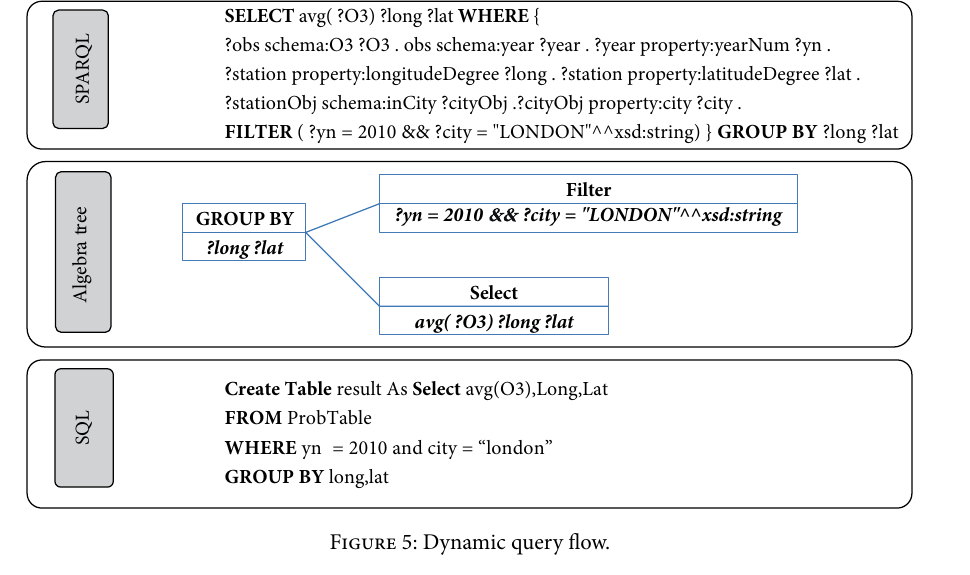
Figure 5: Dynamic query flow.